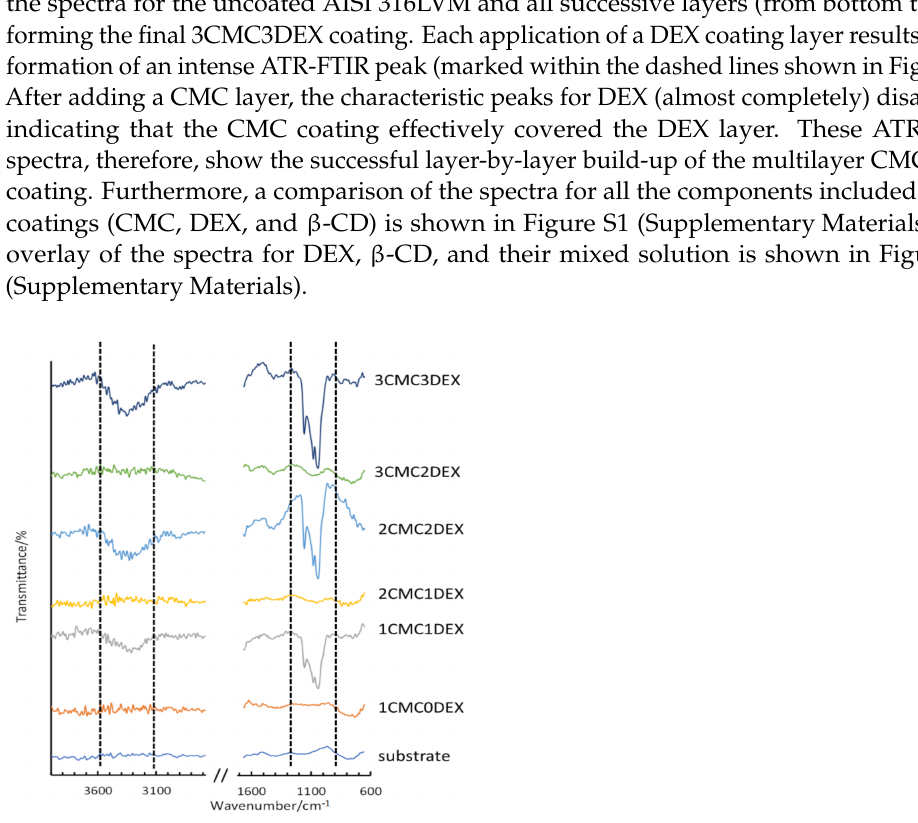
Figure 2. ATR-FTIR measurements on AISI 316LVM after successive application of alternating CMC and DEX